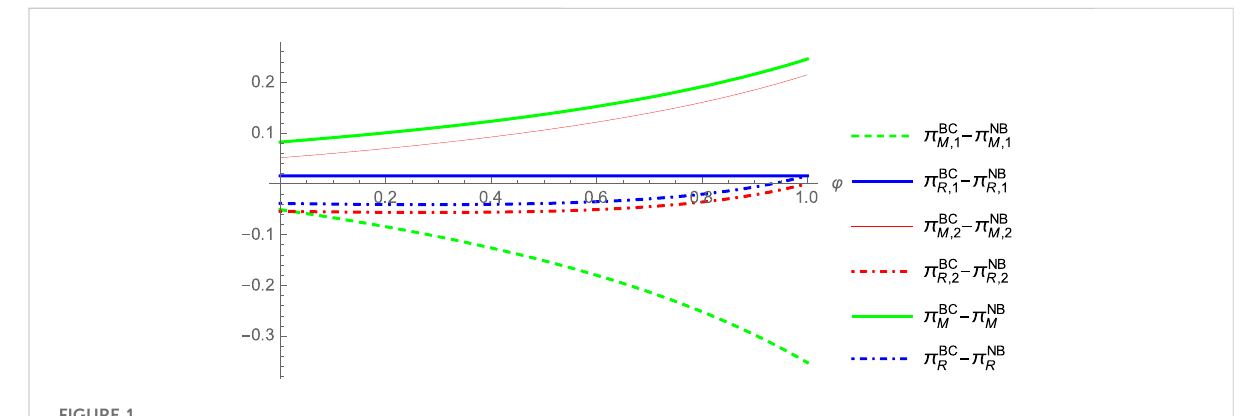
FIGURE 1 The impact of φ on pro fi ts difference in blockchain and noon blockchain